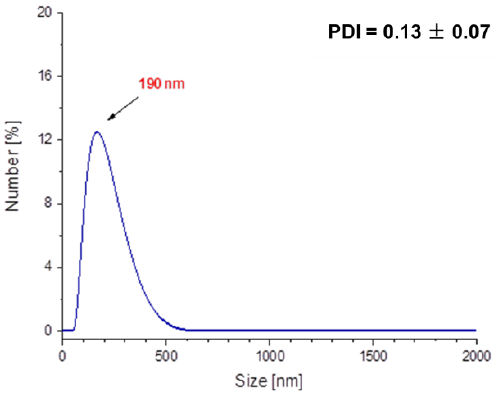
Figure 12. DLS measurement of the Fe 3 O 4 @Ag@PEG particles.